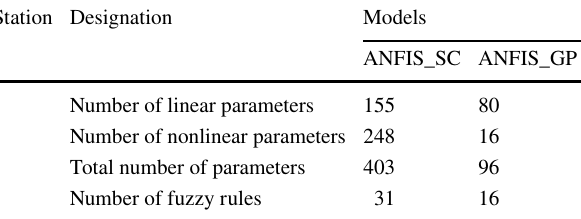
Table 10 Total number of parameters for the two ANFIS models Table 11 Testing results of different function sets and linkage func- tion for developing GEP for USGS 14211720